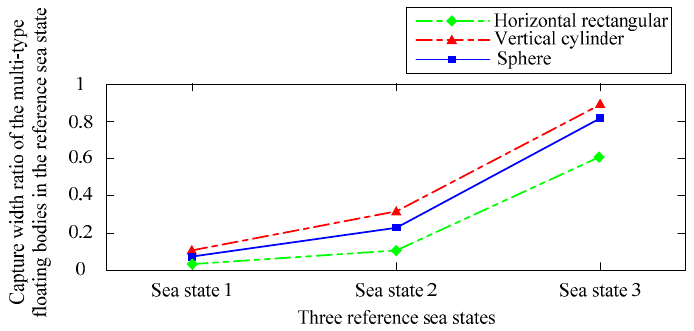
Figure 10. The heaving displacement of the multi-type floating bodies in the reference sea state.